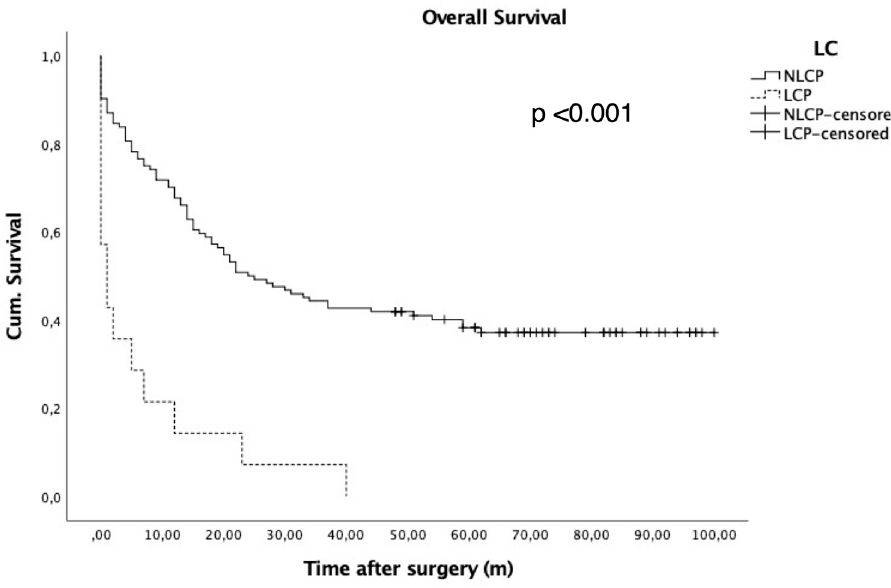
Fig 2. Cumulative Survival curves after esophagectomy of cirrhotic (LCP) and non-cirrhotic patients (NLCP). 1-, 3- and 5-year survival were 79.1%, 44.40% and 32.3% in the NLCP cohort and 21.4%, 7.1% and 0.0% in the LCP group. 19.2% of NLCP were lost to follow-up and excluded from